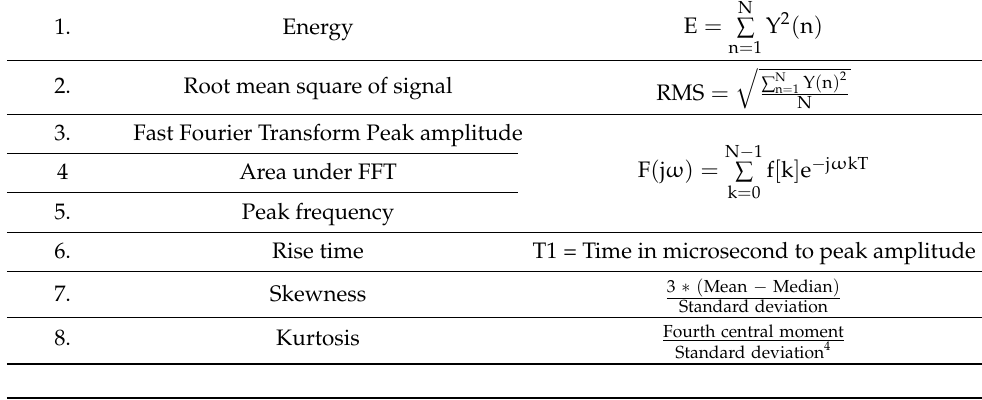
Algorithm 1: K-mean